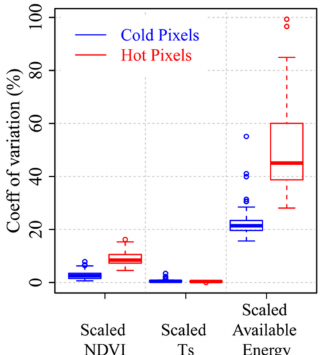
Figure 4. Coefficient of variation of scaled values of normalized difference vegetation index (NDVI), T s , and Available Energy for hot (red) and cold (blue) pixels for all